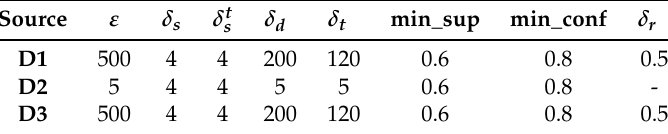
Table 7. Parameter-setting table corresponding to this experiment